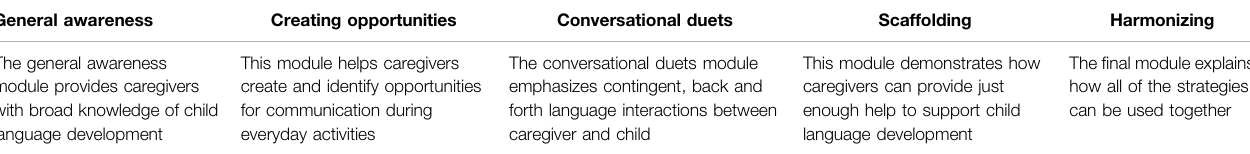
TABLE 2 | Duet language intervention modules.